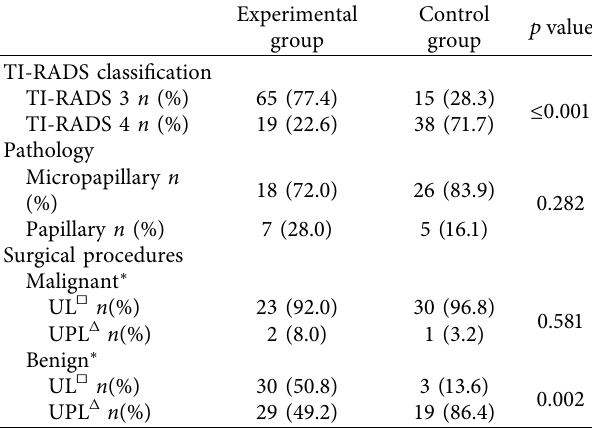
Table 4: Characteristics and surgical procedures of the a-side of the experimental group and the control